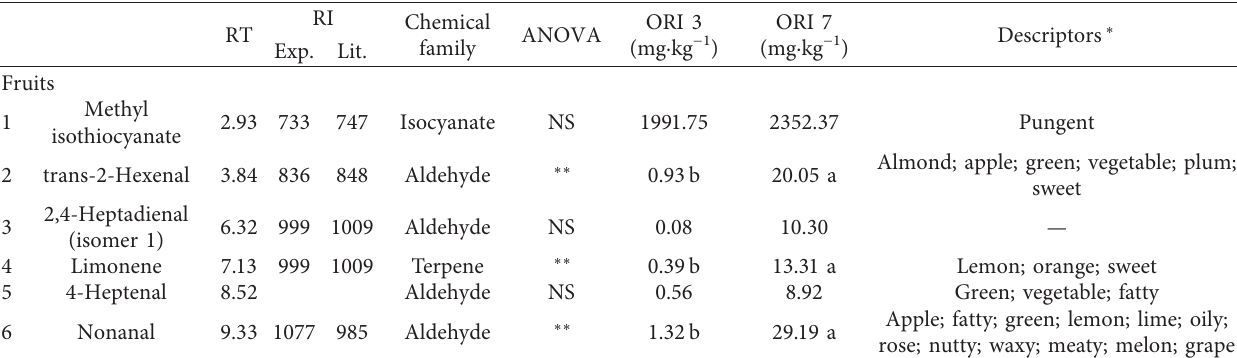
Table 5: Volatile compounds of Capparis spinosa L. in fruits detected using headspace solid phase microextraction (HS-SPME) with GC-